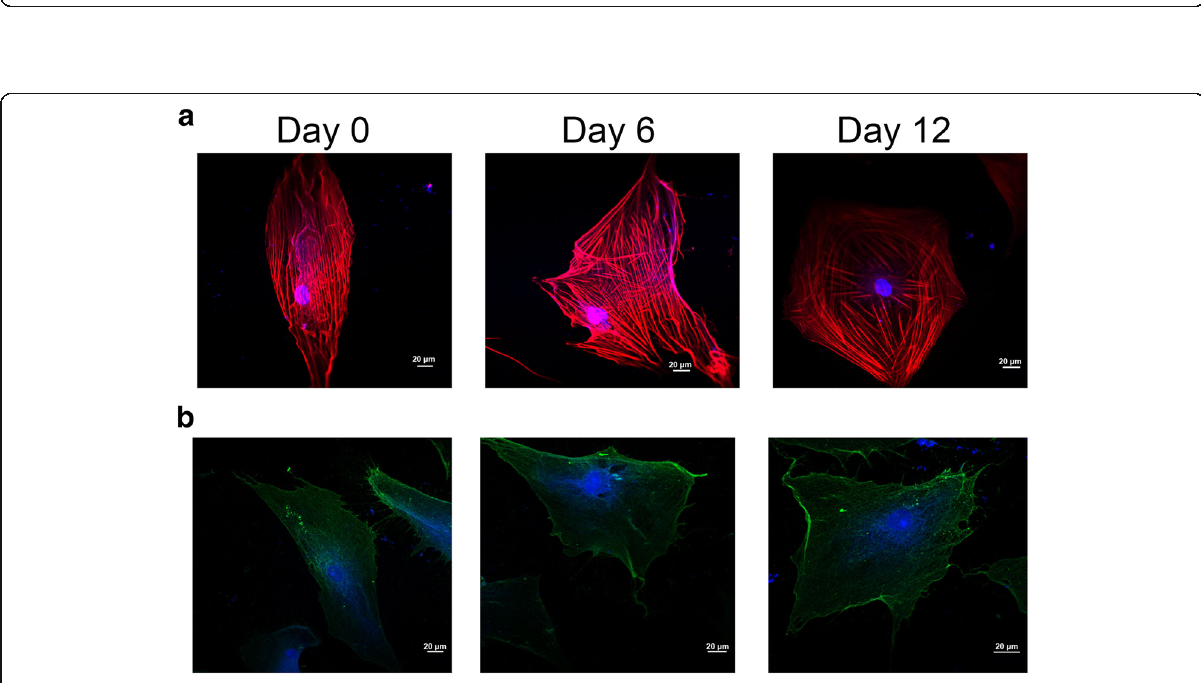
Fig. 3 Organization of the cytoskeleton and location of integrin β 1 on chondrogenically differentiating hADSc. a Changes in cytoskeleton were detected during chondrogenesis of hADSc by confocal microscopy. b The location of integrin β 1 was measured during chondrogenic differentiation by confocal microscopy. Cytoskeleton and nucleus were stained with F-actin and DAPI, respectively. The red and blue fluorescence signals respectively indicate F-actin and